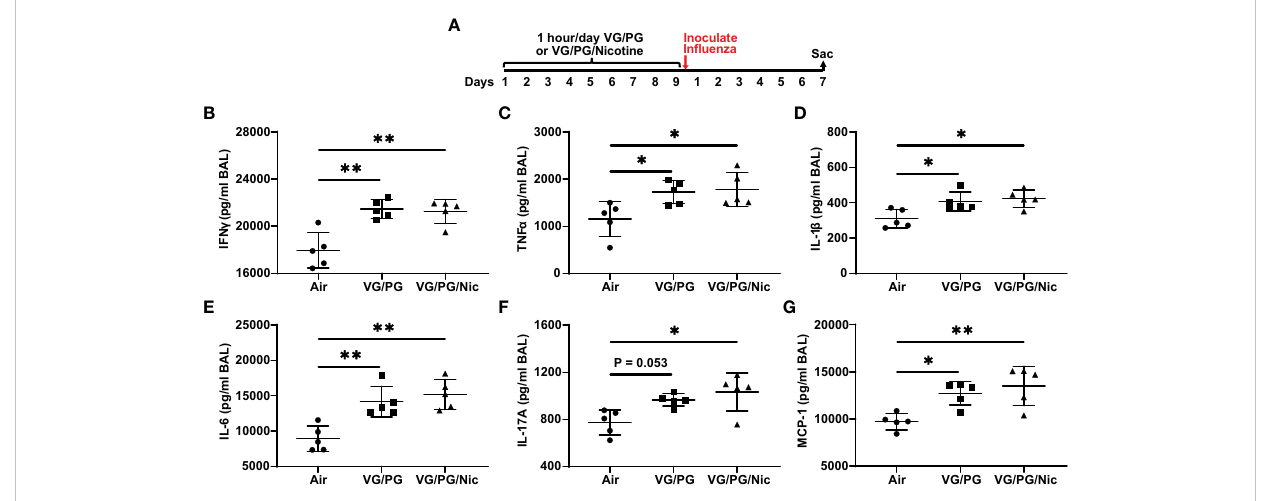
FIGURE 4 E-cigarette aerosol exposure increases in fl uenza-induced production of key in fl ammatory cytokines in the airspaces 7 days after infection. (A) Timeline of the experiment. B-G: Infection with in fl uenza resulted in BAL concentrations of interferon- g , IFN- g (B) , tumor necrosis factor a , TNF a (C) , interleukin-1 b , IL-1 b (D) , IL-6 (E) , IL-17A (F) , and monocyte chemoattractant protein-1, MCP-1 (G) , that were greater in mice exposed to e- cigarette aerosols with (VG/PG/Nic) or without (VG/PG) nicotine compared to control mice (air). This effect could be attributed to the VG/PG that serves as a carrier for other constituents of the e-liquid. * P < 0.05, ** P < 0.01, 1-way ANOVA with Tukey ’ s multiple comparisons test. Data are presented in picogram/milliliter (pg/ml). Each data point represents one